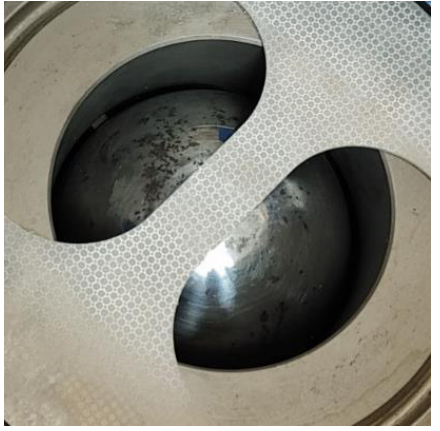
Figure 4. Nakajima test during deformation (source: author).